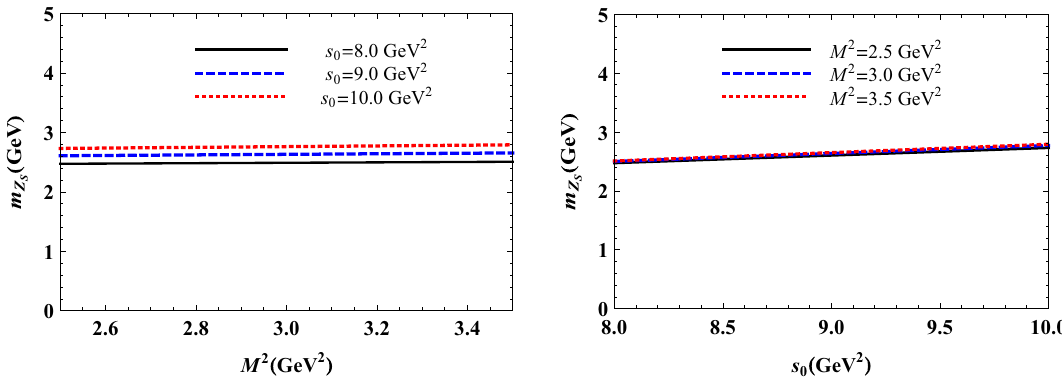
Fig. 4 The mass of the Z S state as a function of the Borel parameter M 2 at fixed values of s 0 (left panel), and as a function of the continuum threshold s 0 at fixed M 2 (right panel)